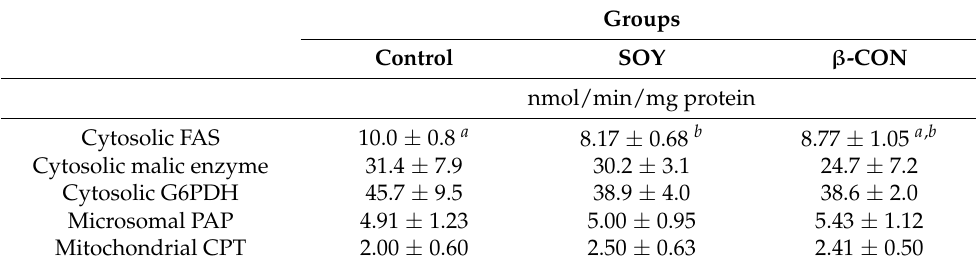
Table 4. Effect of dietary β‐ conglycinin on hepatic enzyme activities in SHR.